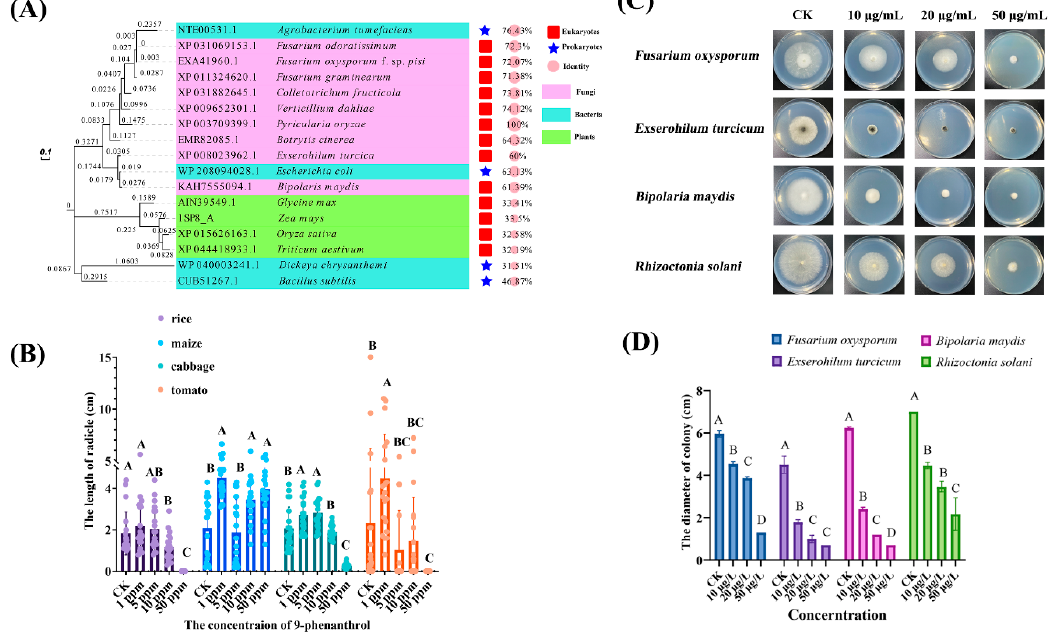
Figure 5. The inhibitory effects of 9-phenanthrol on different plants and fungi. Polygenetic analyses of HDDP in fungi, bacteria, and plants ( A ). Inhibitory rates of 9-phenanthrol on plant germination ( B ) and other fungal pathogens ( C , D ). Values are presented as the mean of results of triplicate experiments ± SD. Bars with different letters indicate significant differences between treatments at a p -value < 0.01 using a Duncan statistics method.